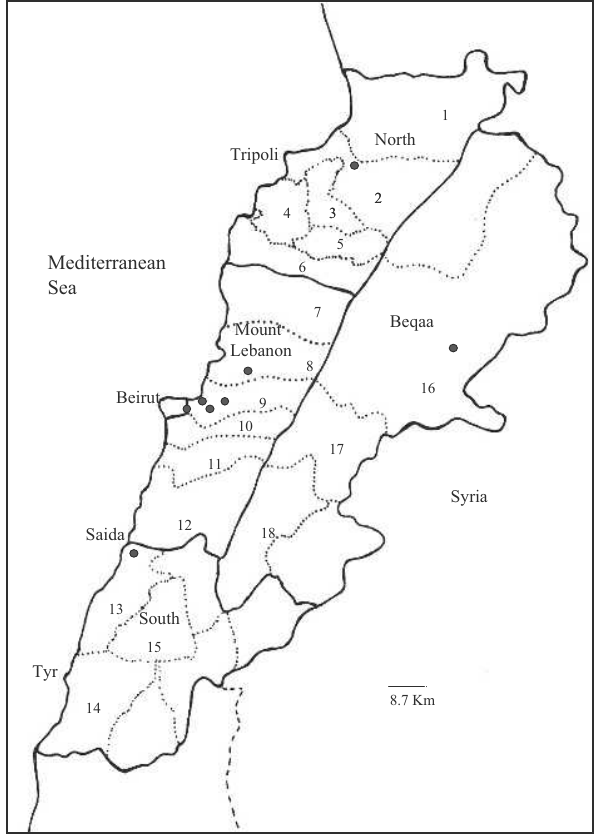
Fig. 1. – Map of Lebanon showing the different counties where mos- quitoes were collected for this survey, and showing the sites of col- lection of Anopheles claviger. (1) Akkar Co.; (2) Tripoli Co.; (3) Zgharta Co.; (4) Koura Co.; (5) Bcharre Co.; (6) Batroun Co.; (7) Jbeil Co.; (8) Kesrouan Co.; (9) Metn Co.; (10) Baabdah Co.; (11) Aaley Co.; (12) Chouf Co.; (13) Saida Co.; (14) Tyr Co.; (15) Nabatiyeh Co.; (16) Baalback Co.; (17) Zahleh Co.; (18) West Beqaa Co. (• denotes sites of collection of An. claviger